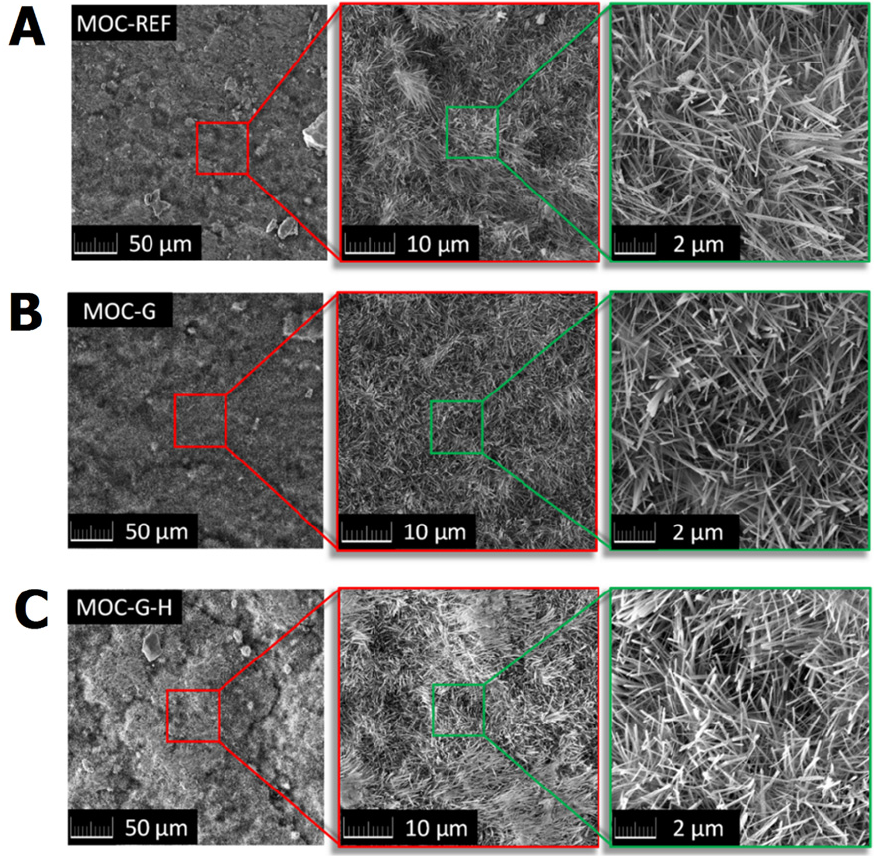
Figure 6. Micrographs of prepared samples: ( A ) MOC-REF, ( B ) MOC-G, and ( C ) MOC-G-H.